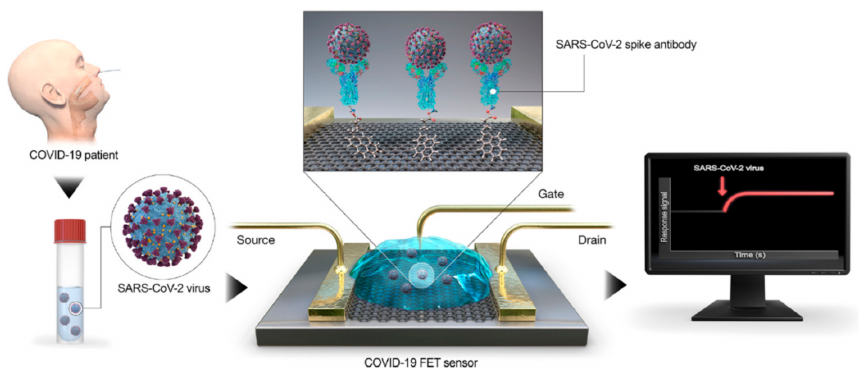
Figure 8. Field-effect transistor (FET) biosensor utilizing spike protein antibodies for detection of re acute respiratory syndrome coronavirus-2 (SARS-CoV-2) obtained through nasopharyngeal swab samples and stored in universal transport medium. This process requires no sample preparation [140]. Reused with permission from ACS